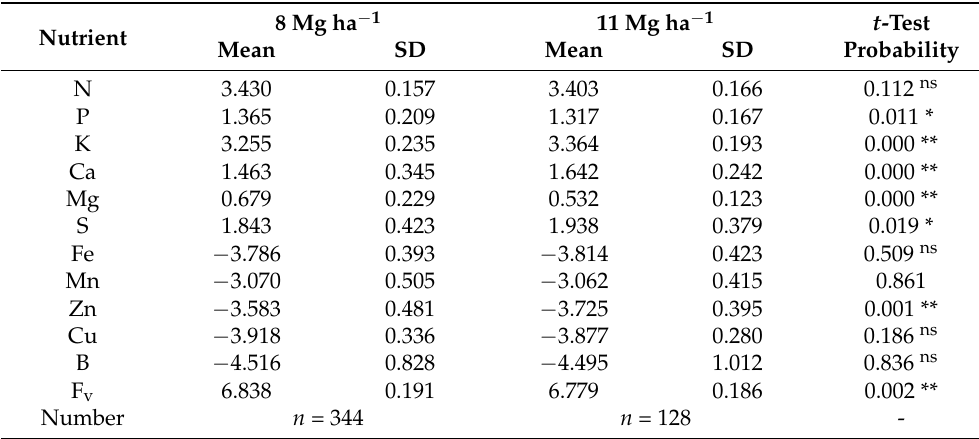
Table 3. Regional centered log ratio means and standard deviation computed across n true negative specimens at garlic yield cutoffs of 8 Mg or 11 Mg marketable yield ha − 1 ,